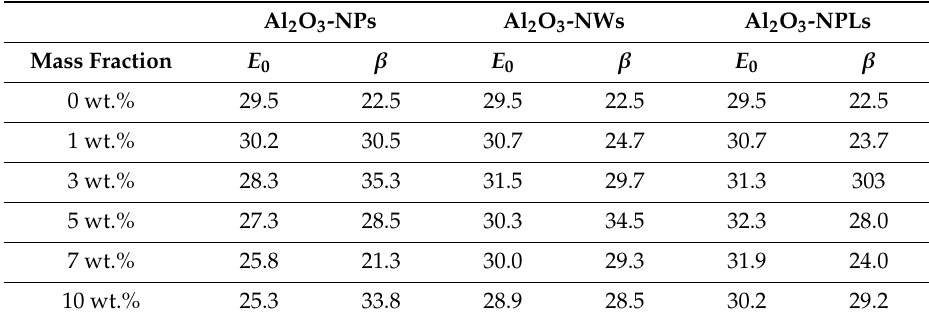
Figure 9. Weibull distribution of composite AC breakdown strength with different mass fractions of Al 2 O 3 nano-fillers: ( a ) Al 2 O 3 -NPs, ( b ) Al 2 O 3 -NWs, and ( c ) Al 2 O 3 -NPLs. Table 1. Weibull distribution parameters of composite AC breakdown strength with different mass fractions of Al 2 O 3 -NPs, Al 2 O 3 -NWs and Al 2 O 3 -NPLs.